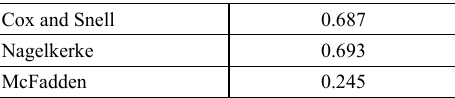
Table 1. Analysis of the pseudo R-square values